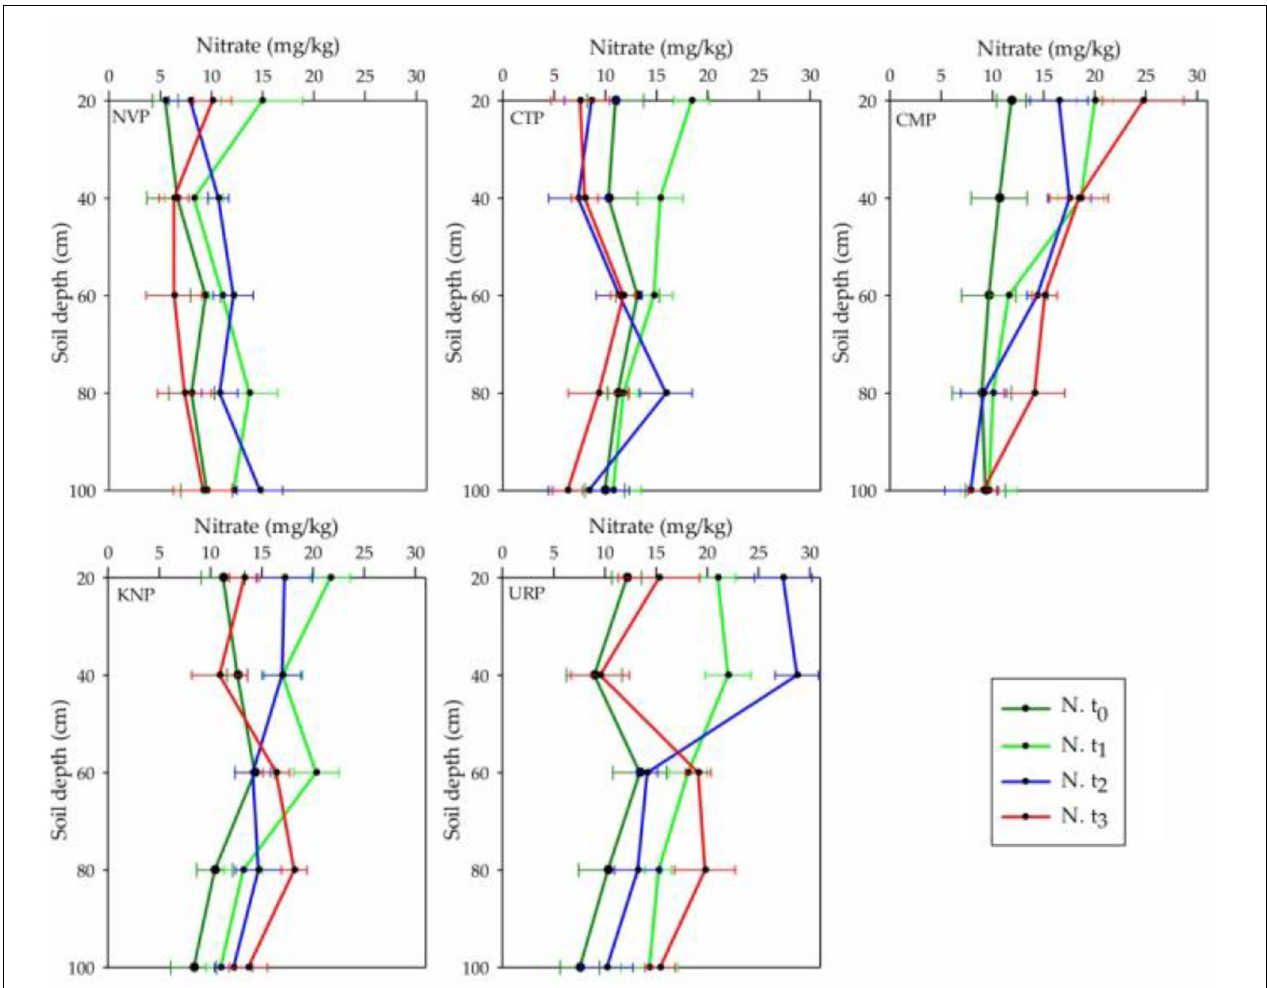
FIGURE 4 | Nitrate mean and standard bar values in the different layers of soil profile 0–100 cm in the treatment plots of Chinese cabbage for the time periods t 0 , t 1 , t 2 , and t 3 in the cropping season at Shunyi District,